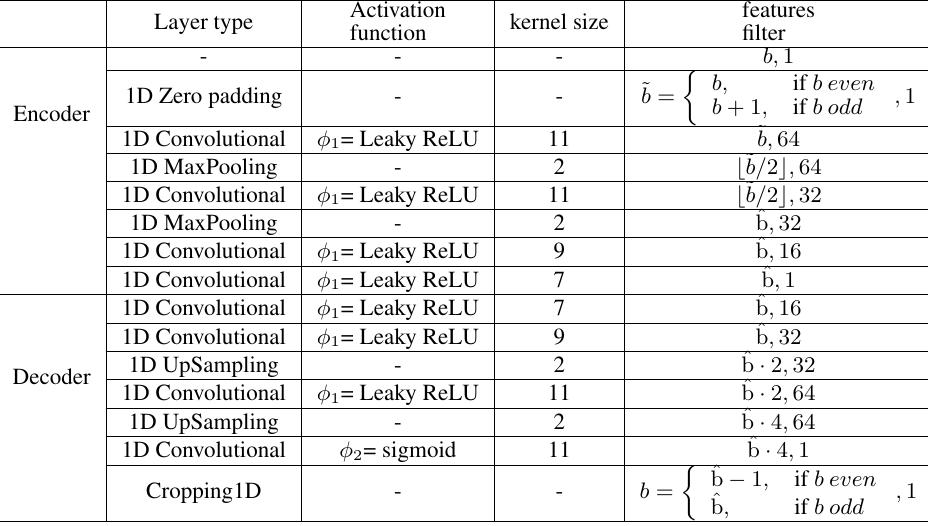
Table 1. Structure of the 1D-Convolutional Autoencoder